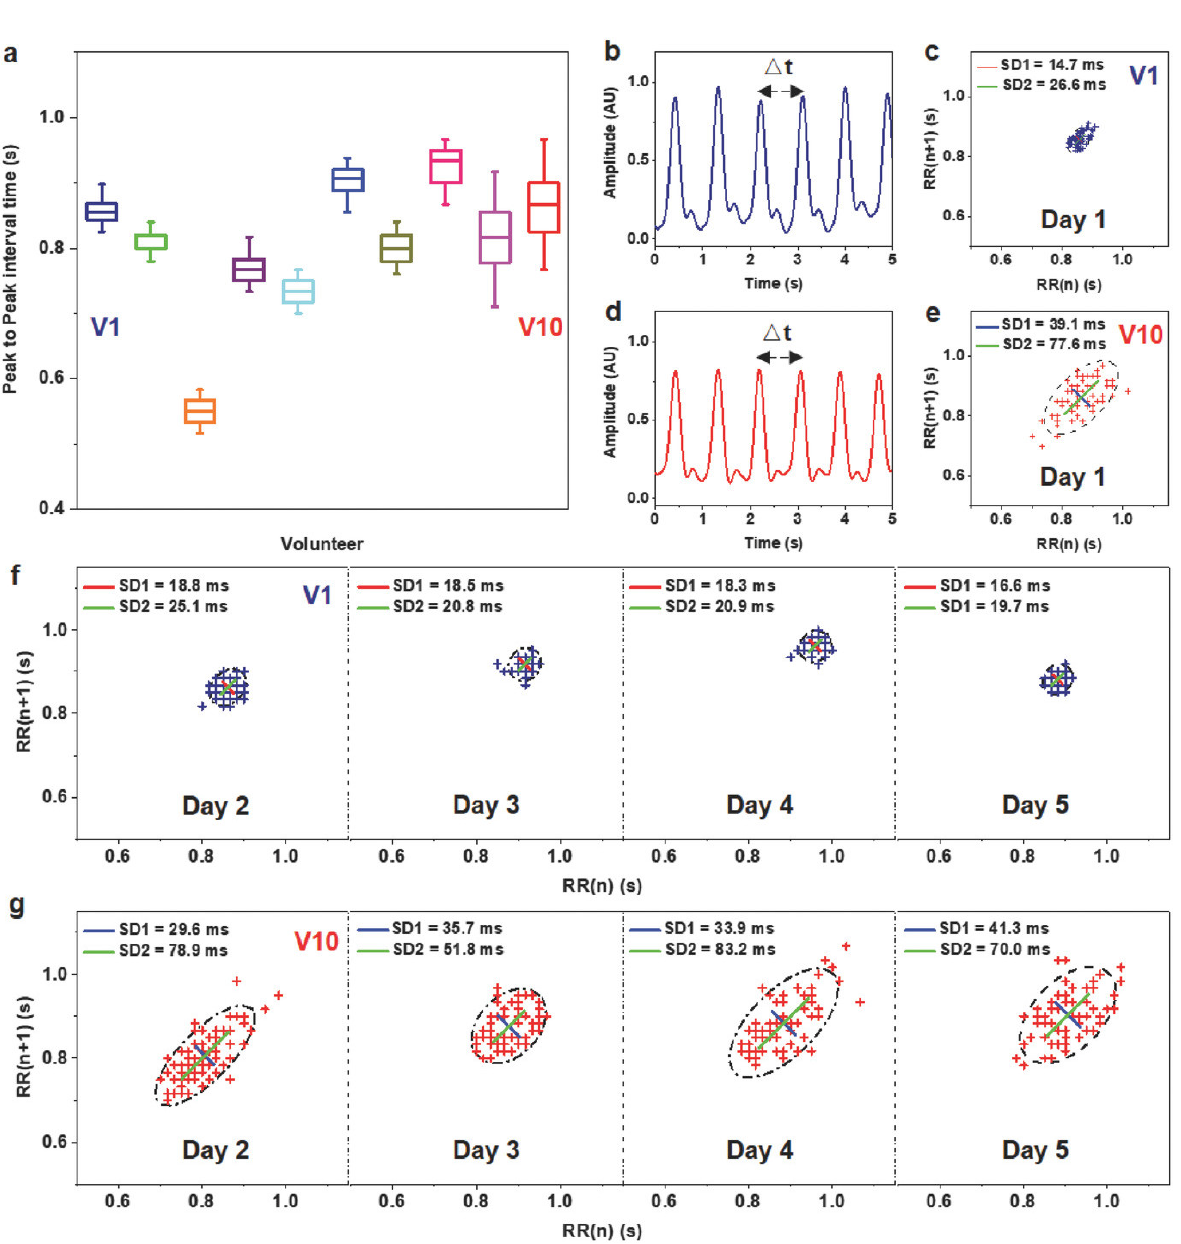
Figure 24. Results of the pulse waves at the Cun, Guan, and Chi regions of the radial artery of the wrist from a human body that were measured employing a three-channel pulse sensing array [112]. ( a ) Representation of the pulse-sensing array placed at the Cun, Guan, and Chi regions. ( b ) Signal processing of the pulse-sensing array. Results of normalized Cun, Guan, and Chi pulse signals for ( c ) a 26-year-old female volunteer, and ( d ) a 28-year-old male volunteer. Reprinted with permission from [112]. Copyright  2018, WILEY-VCH Verlag GMbH & Co. KGaA, Weinheim.